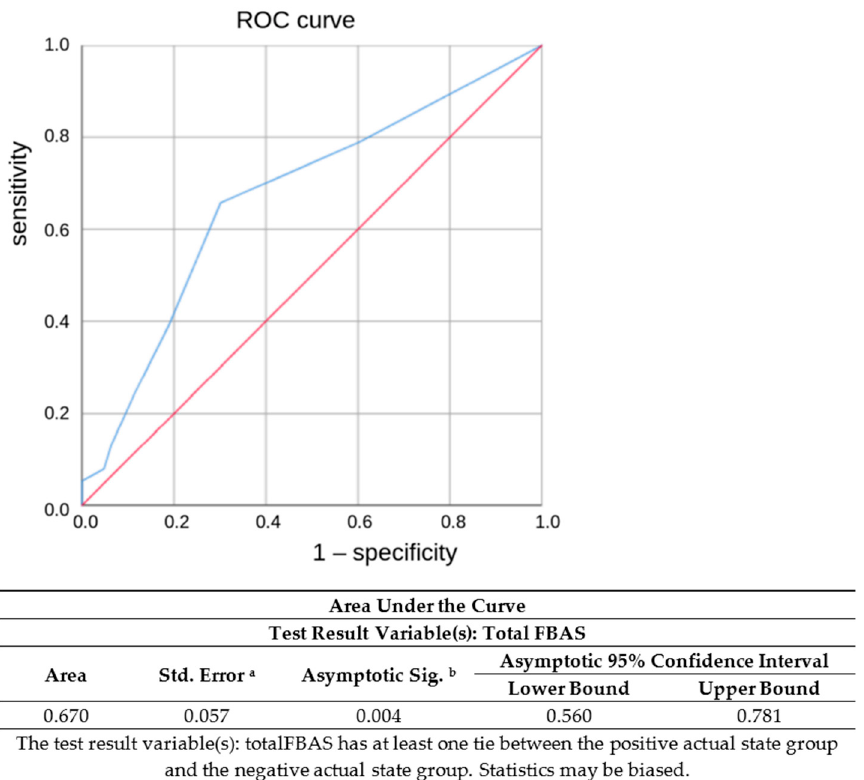
Figure 1. Receiver operating characteristic (ROC) curve for the ability of the Functional Bedside Screen (FBAS) to predict aspiration risk in ischemic stroke.